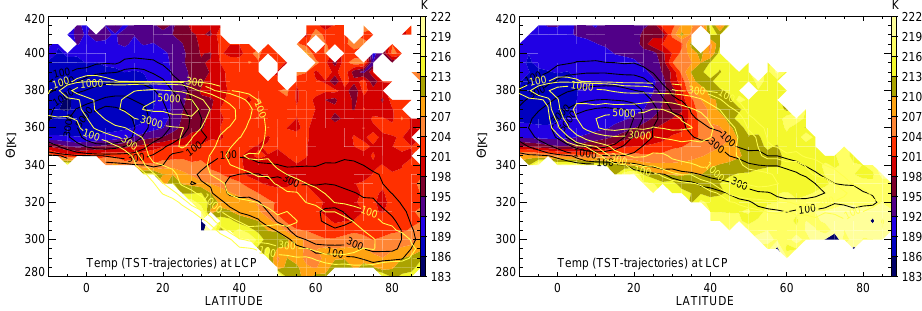
Fig. 6. Zonal mean cross section of T LCP at the location of LCP of each TST trajectory for northern winter (left) and summer (right). Colours are as in Fig. 5, black contours denote the number of trajectories at their location of LCP, yellow contours indicate the number of trajectories at their individual TST location (both number contours from 2 . 5 ◦ × 5 K-bins).